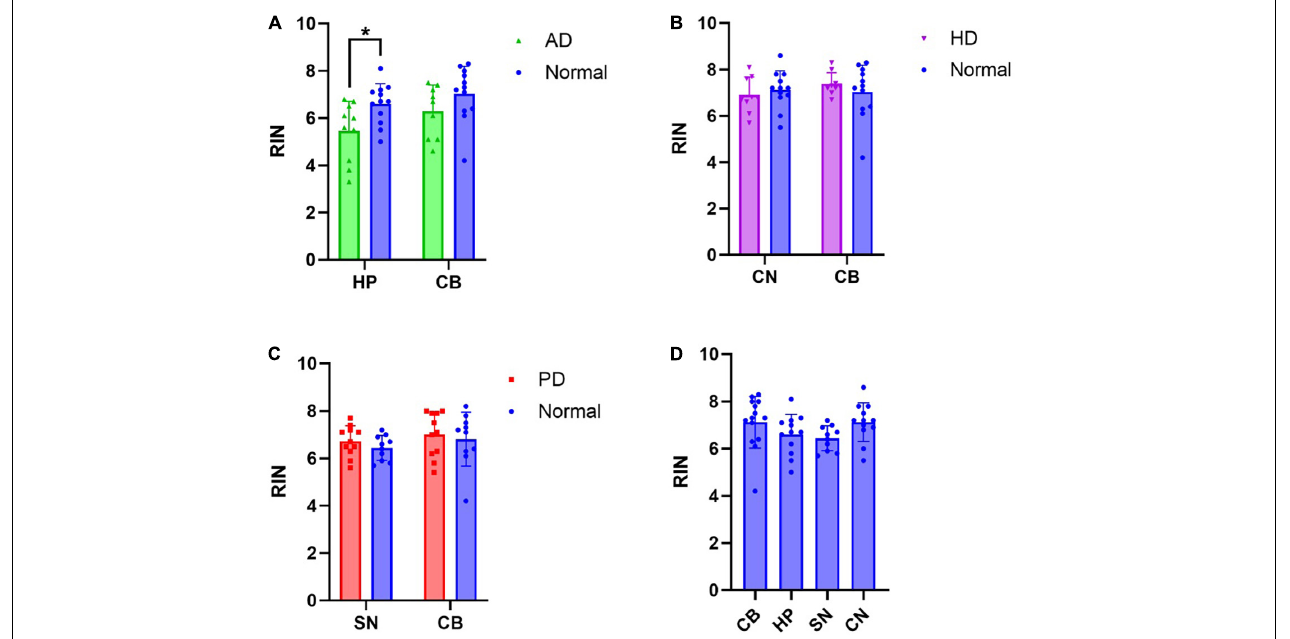
FIGURE 1 | RNA integrity number (RIN) is decreased in Alzheimer’s disease hippocampus: RIN values from RNA extracted from disease affected and unaffected regions were compared between disease groups and neurologically normal cases, as well as across all regions of neurologically normal cases. (A) A significant decrease in RIN was observed in the AD HP. (B) No significant differences in RIN were observed in the CN or CB in HD. (C) No significant differences in RIN were observed in the SN or CB in PD. (D) RIN did not differ by region in normal cases. ∗ p < 0 .